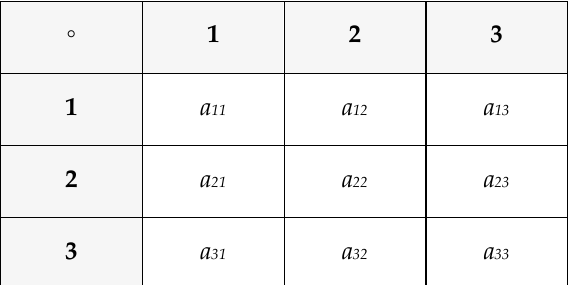
Table 11. General form of a 3-element magma’s Cayley table